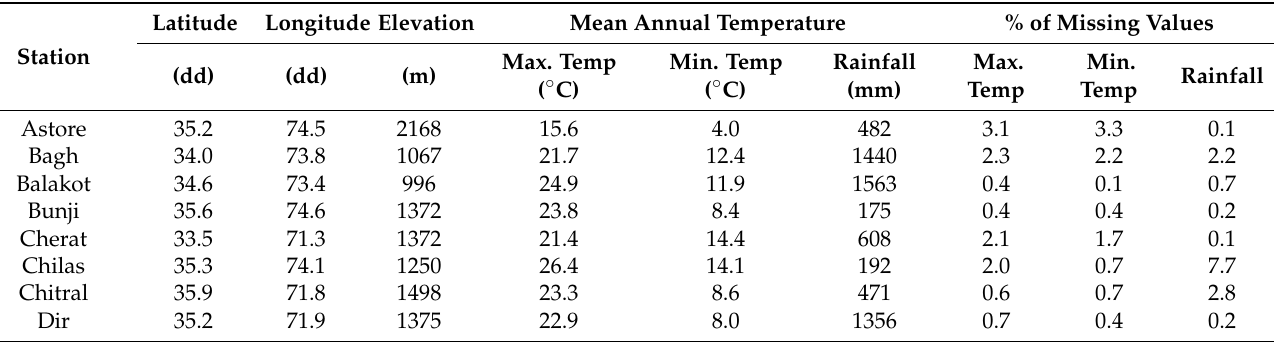
Table 1. Meteorological stations used in